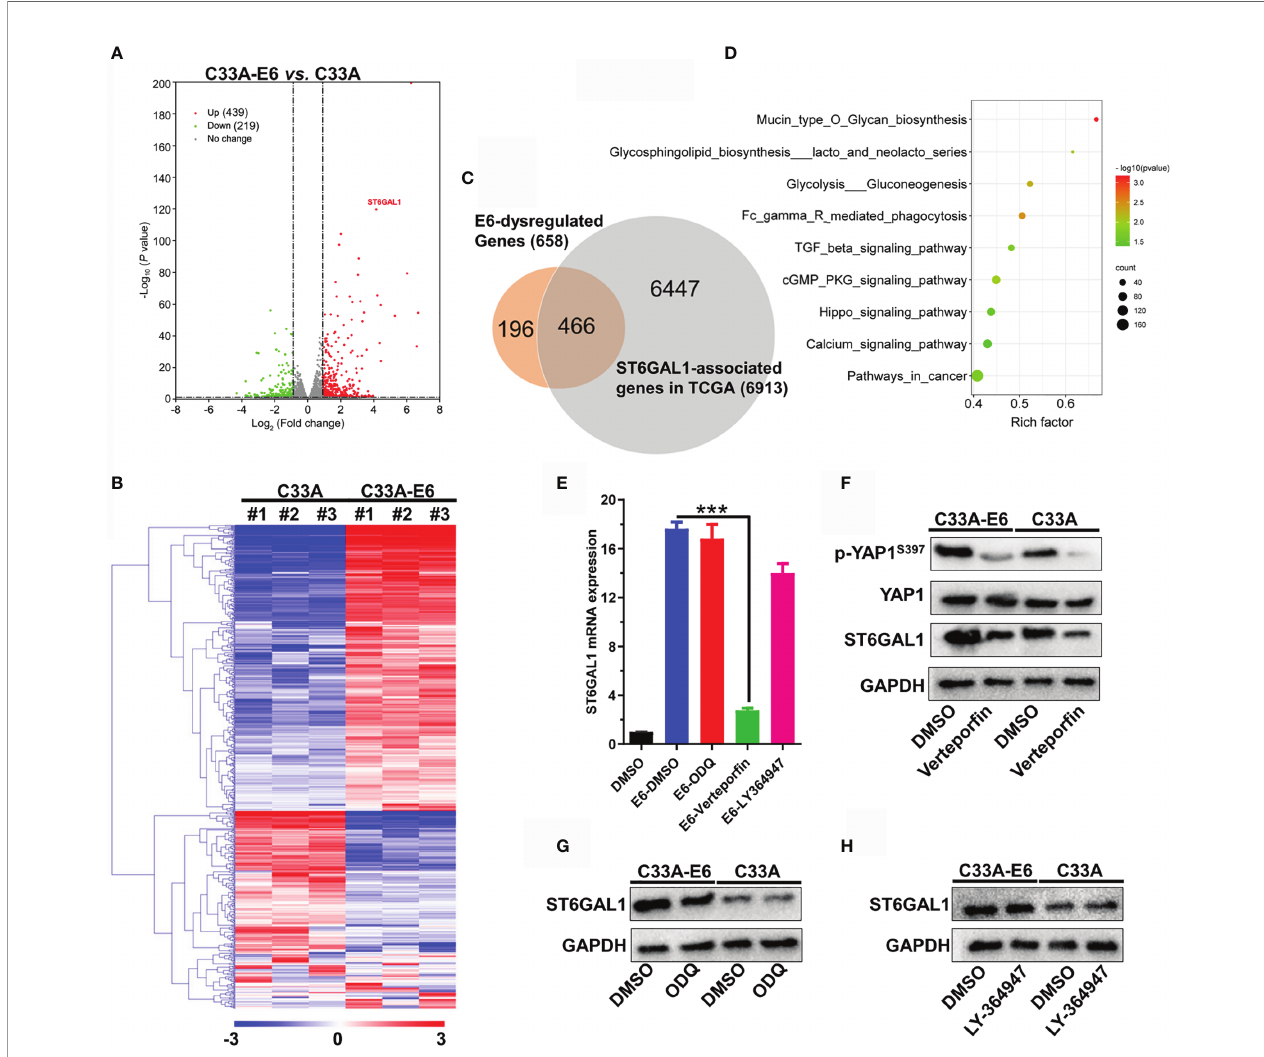
FIGURE 4 | HPV16 E6 promotes ST6GAL1 expression by activating Hippo signaling pathway. (A) Dysregulated mRNAs between C33A and C33A-E6 (E6 stable expressing) cells were detected by mRNA sequencing. (B) Heat map and hierarchical clustering analysis of 658 dysregulated mRNAs with three independent biological replicates were presented. (C) Venn diagram of 658 E6-dysregulated mRNAs and 6,913 ST6GAL1-asscociated mRNAs in TCGA dataset (N = 305). ST6GAL1-associated mRNAs were identi fi ed using R2: Genomics Analysis and Visualization Platform (http://r2.amc.nl). (D) KEGG enrichment analysis of 466 mRNAs that simultaneously associated with E6 and ST6GAL1. (E) C33A and C33A-E6 cells were treated with vertepor fi n (5 m M, Hippo signaling inhibitor), ODQ (10 m M, cGMP/PKG inhibitor), and LY-364947 (5 m M, TGF- b inhibitor) for 24 h, and then, qRT-PCR was used to detect ST6GAL1 mRNA expression. DMSO was used as solvent control. ST6GAL1 protein expression of C33A and C33A-E6 cells in response to (F) vertepor fi n, (G) ODQ, and (H) LY-364947 treatment was detected by Western blot. Data were presented as mean ± SD from the three independent replicates. *** p <